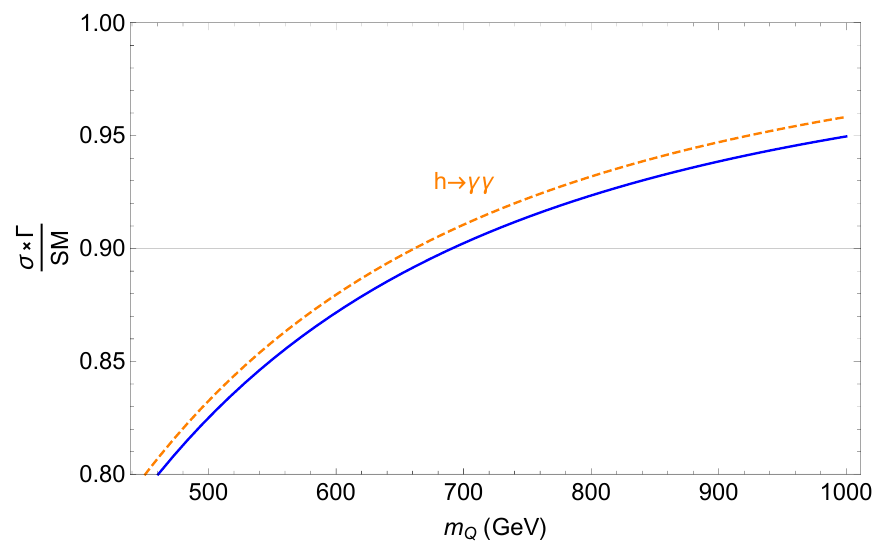
Figure 3 . Ratio of the production of a the Higgs boson and subsequent prompt decay into SM (cid:12)nal states as a function of m Q . The h (cid:13)(cid:13) line is given by the dashed orange curve, while all ! other prompt SM (cid:12)nal states fall along the solid blue